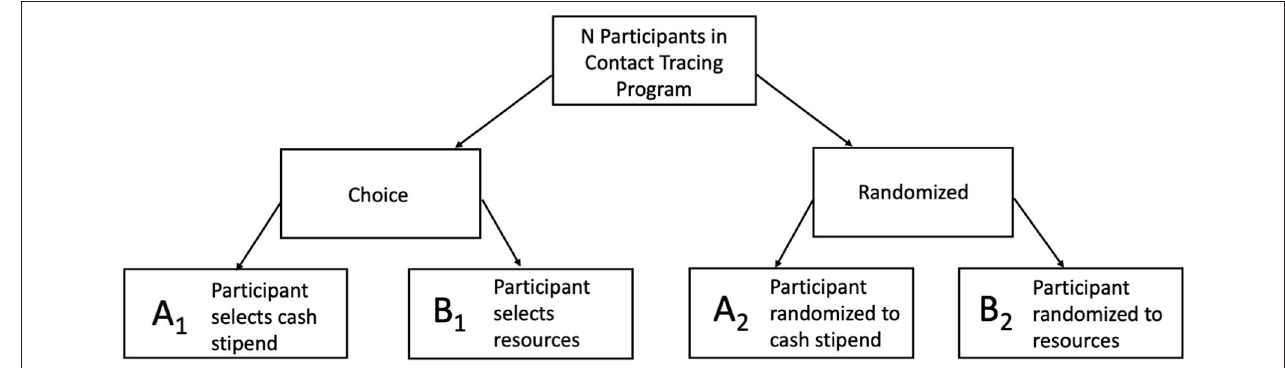
FIGURE 3 | Two-Stage Preference Design for Contact Tracing Quarantine Incentives. The comparison of uptake of A 1 vs. B 1 shows the selection effect. Is there differential uptake of these two programs? If yes, then there is a difference in the groups’ overall selection likelihood. The comparison of outcomes of A 2 vs. B 2 shows the difference between two programs through a controlled trial design. For example, for the research question: Is there a difference in measures of successful completion of quarantine between the two programs? The comparison of outcomes of A 1 vs. A 2 and B 1 vs. B 2 shows the preference effect. For example, if more participants who selected cash stipend (A 1 ), were likely to complete their second COVID-19 test than those who were randomized to cash stipend (A 2 ).